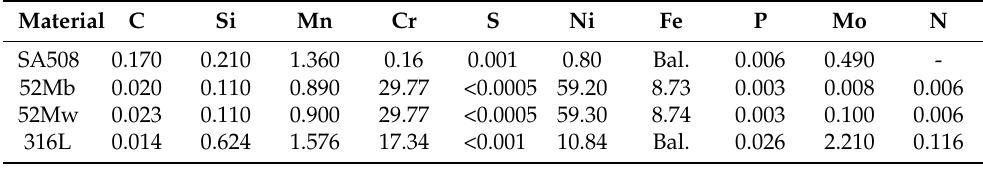
Table 1. Chemical composition of materials used in dissimilar metal weld joints (DMWJs) [26].